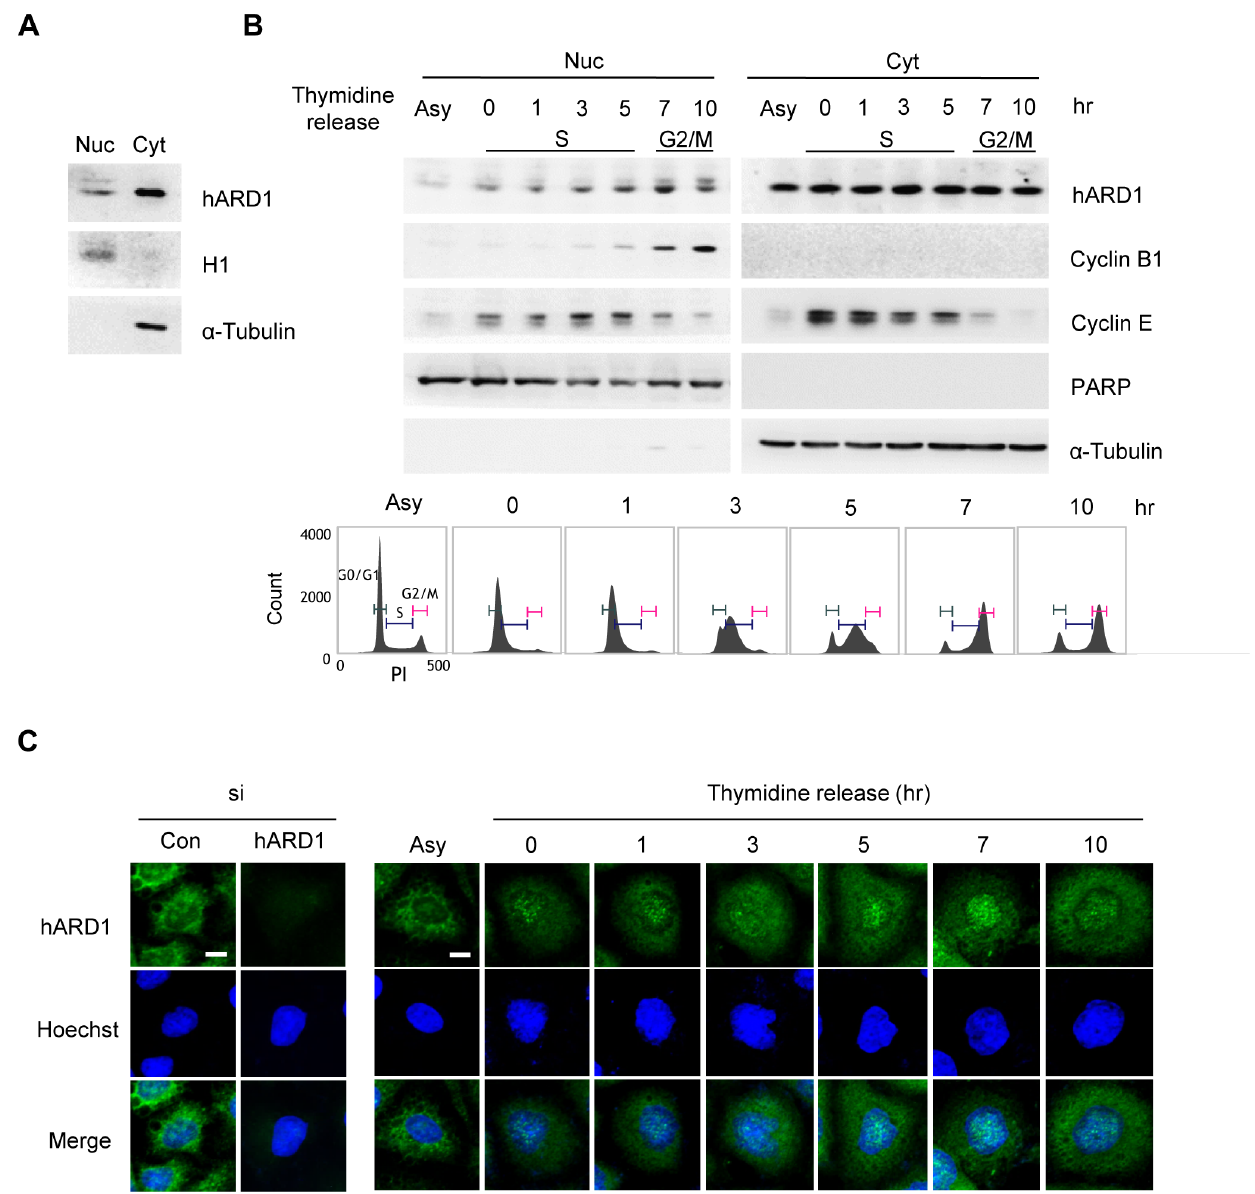
Figure 1. Nuclear hARD1 levels increase during the S phase. A . hARD1 predominantly localizes to the cytoplasm of HeLa cells. HeLa cell lysate was subjected to nuclear/cytosolic fractionation, and hARD1 in each compartment was analyzed by immunoblotting. Histone H1 and a -tubulin were included as nuclear and cytoplasmic markers, respectively. Nuc, nuclear protein; Cyt, cytosolic protein. B and C . hARD1 translocates to the nucleus during S phase. B, HeLa cells were synchronized at the early S phase by double thymidine block, which was released for the indicated times, and then hARD1 subcellular localization was analyzed by performing western blot. Approximations of the cell cycle stages were based on the level of cyclins and were confirmed using flow cytometry. PARP and a -tubulin were included as nuclear and cytoplasmic markers, respectively. Asy, asynchronized cells. C, hARD1 subcellular localization was assessed by immunofluorescence staining. The nuclei were labeled with Hoechst (blue). Scale bar, 10 m m.